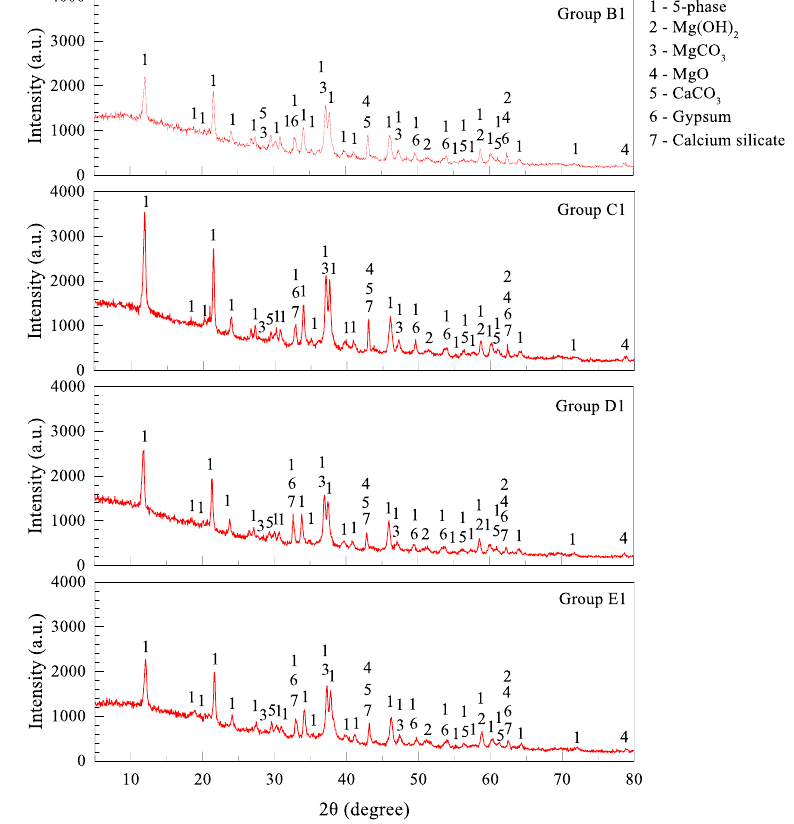
Figure 13. XRD curves of MOC samples with solid wastes.